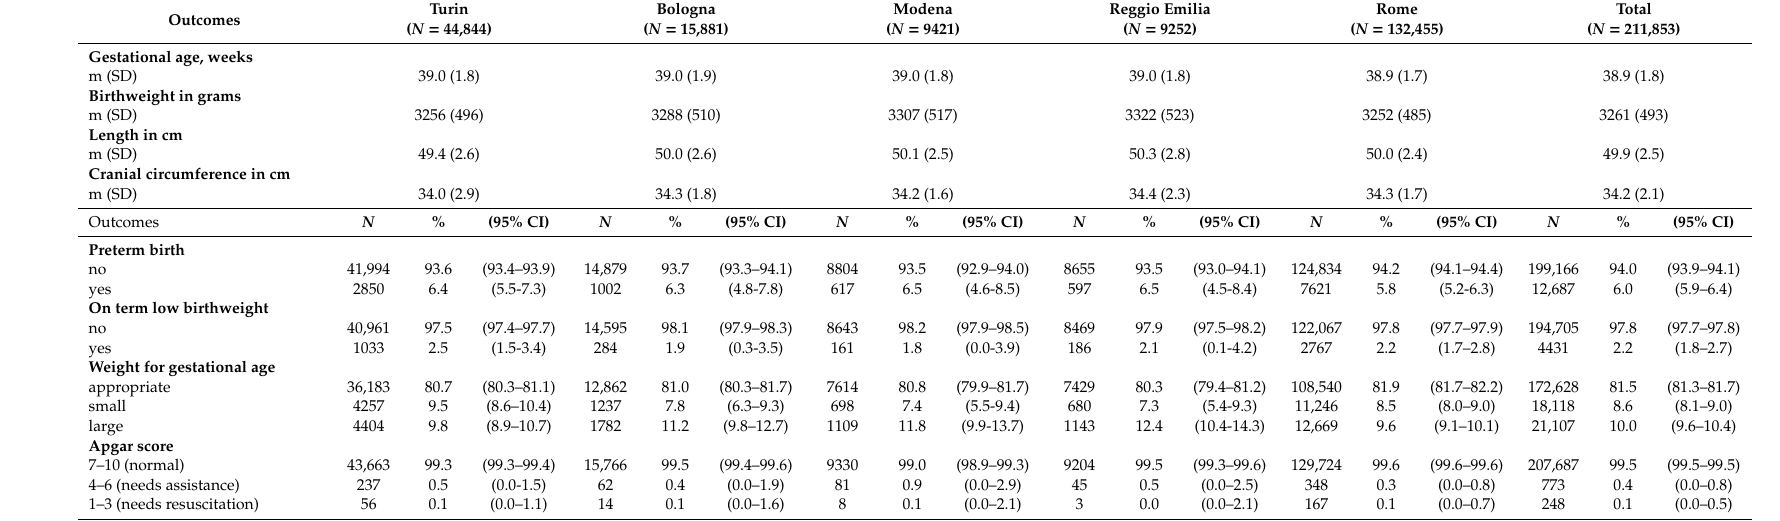
Table 4. Pregnancy